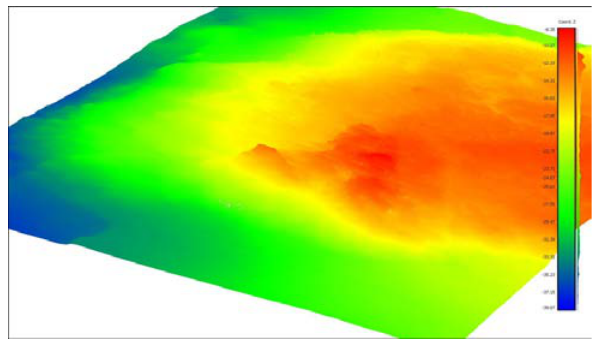
Figure 3. Acoustic bathymetry of the seabed in which the underwater archaeological site of Cala Minnola